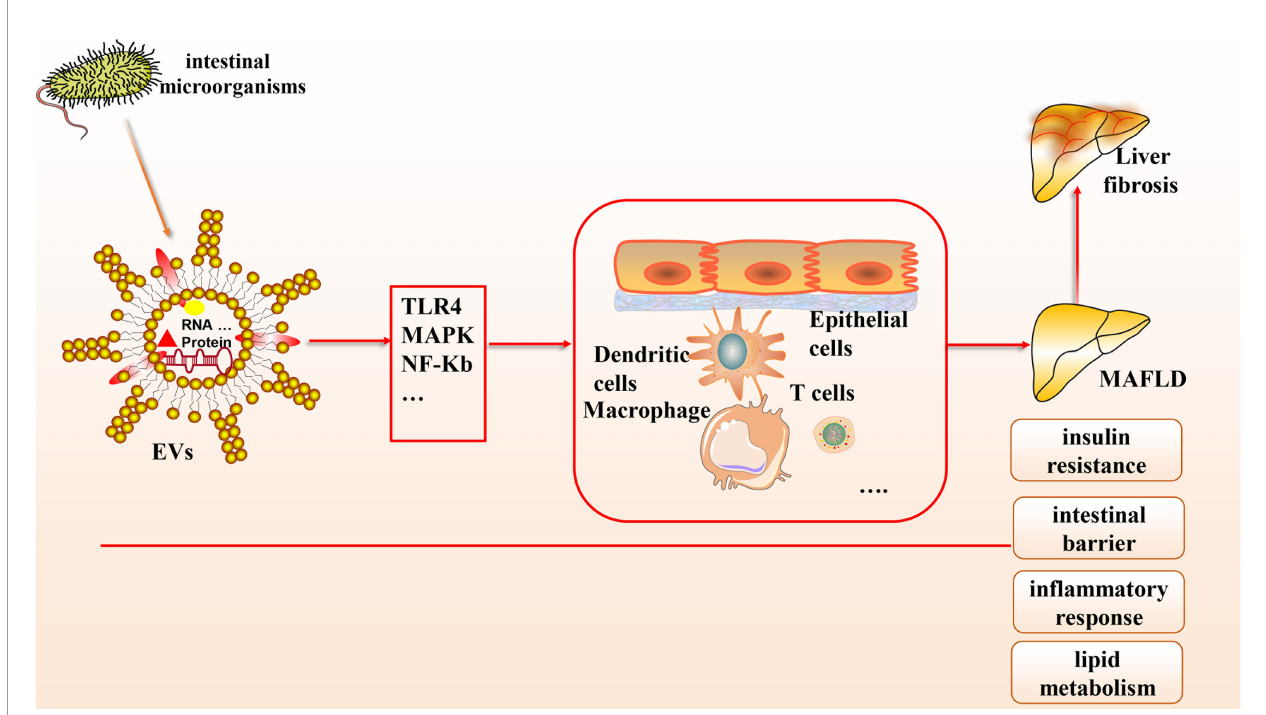
FIGURE 1 | The connection between gut microbial-derived exosomes and MAFLD. Many microorganisms exist in the human body, which can secrete EVs, a bilayer lipid membrane structure that can include the outermost LPS, cytoplasmic and membrane-bound proteins, DNA, multiple protein components, etc. Based on the gut-liver axis theory, EVs can carry various biological mediators and affect multiple cells through many signaling pathways to in fl uence pathological mechanisms in MAFLD, including intestinal barrier homeostasis, insulin resistance, lipid metabolism, in fl ammatory response,